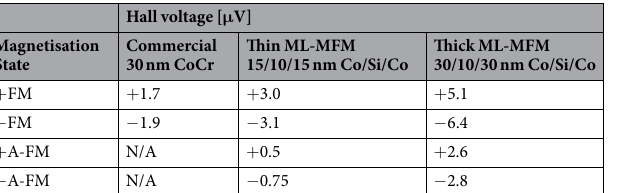
Table 2. Summary of peak V H values extracted from Fig. 6 for commercial, thin and thick ML-MFM